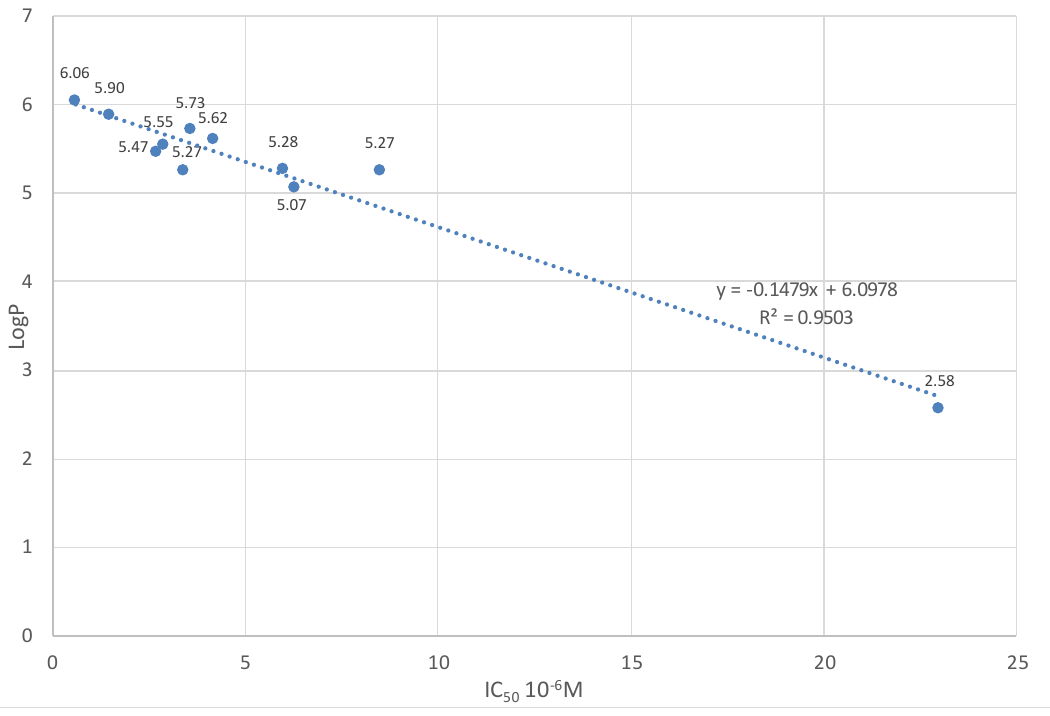
Figure 4. Correlation diagram between Tdp-1 inhibition IC 50 and logP of nucleoside derivatives for compounds 2a – 2g , 4a , 6 – 7 and 9 with exclusion of the data for compounds 5 , 8 .